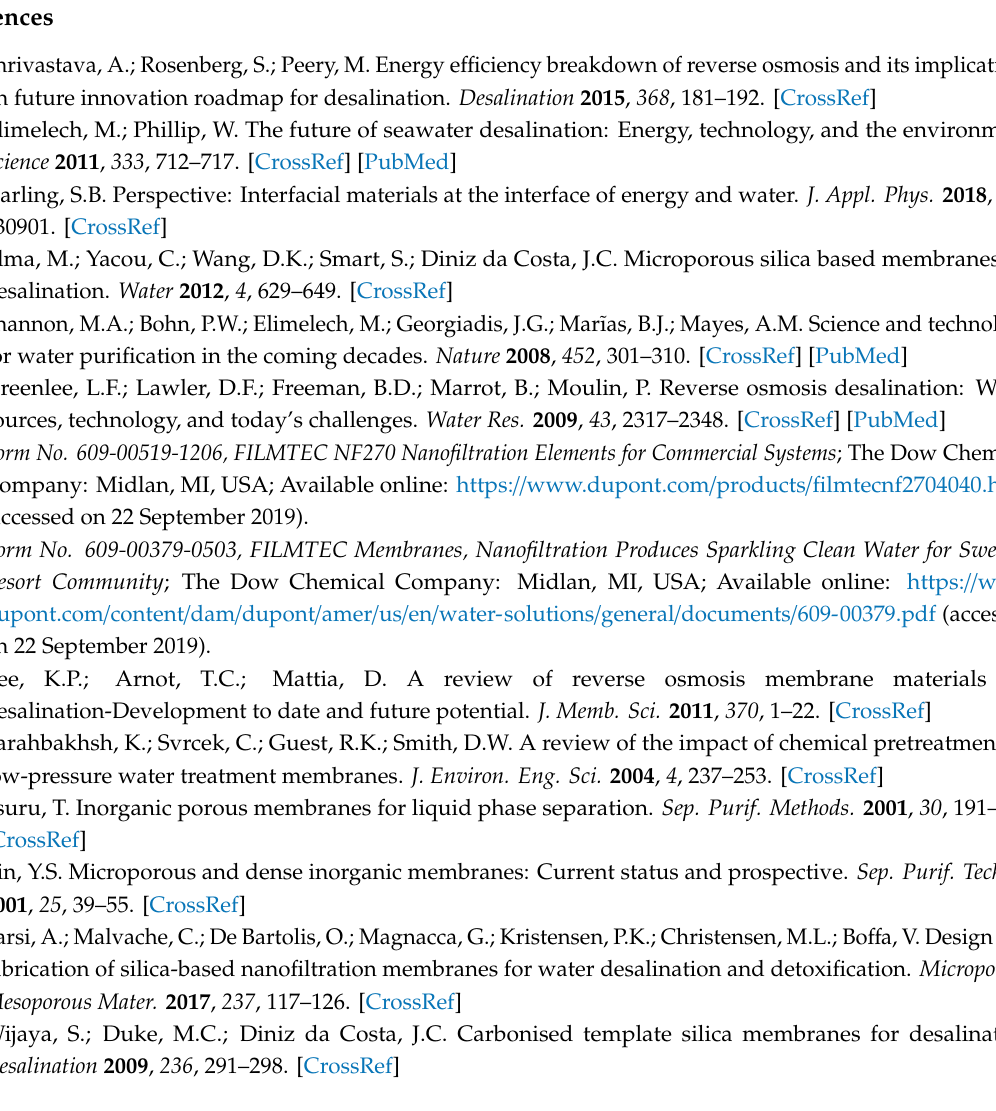
Table S1: MS-MS conditions of organic pollutants detected in the sample (DP-declustering potential, EP extensions potential, CE collision